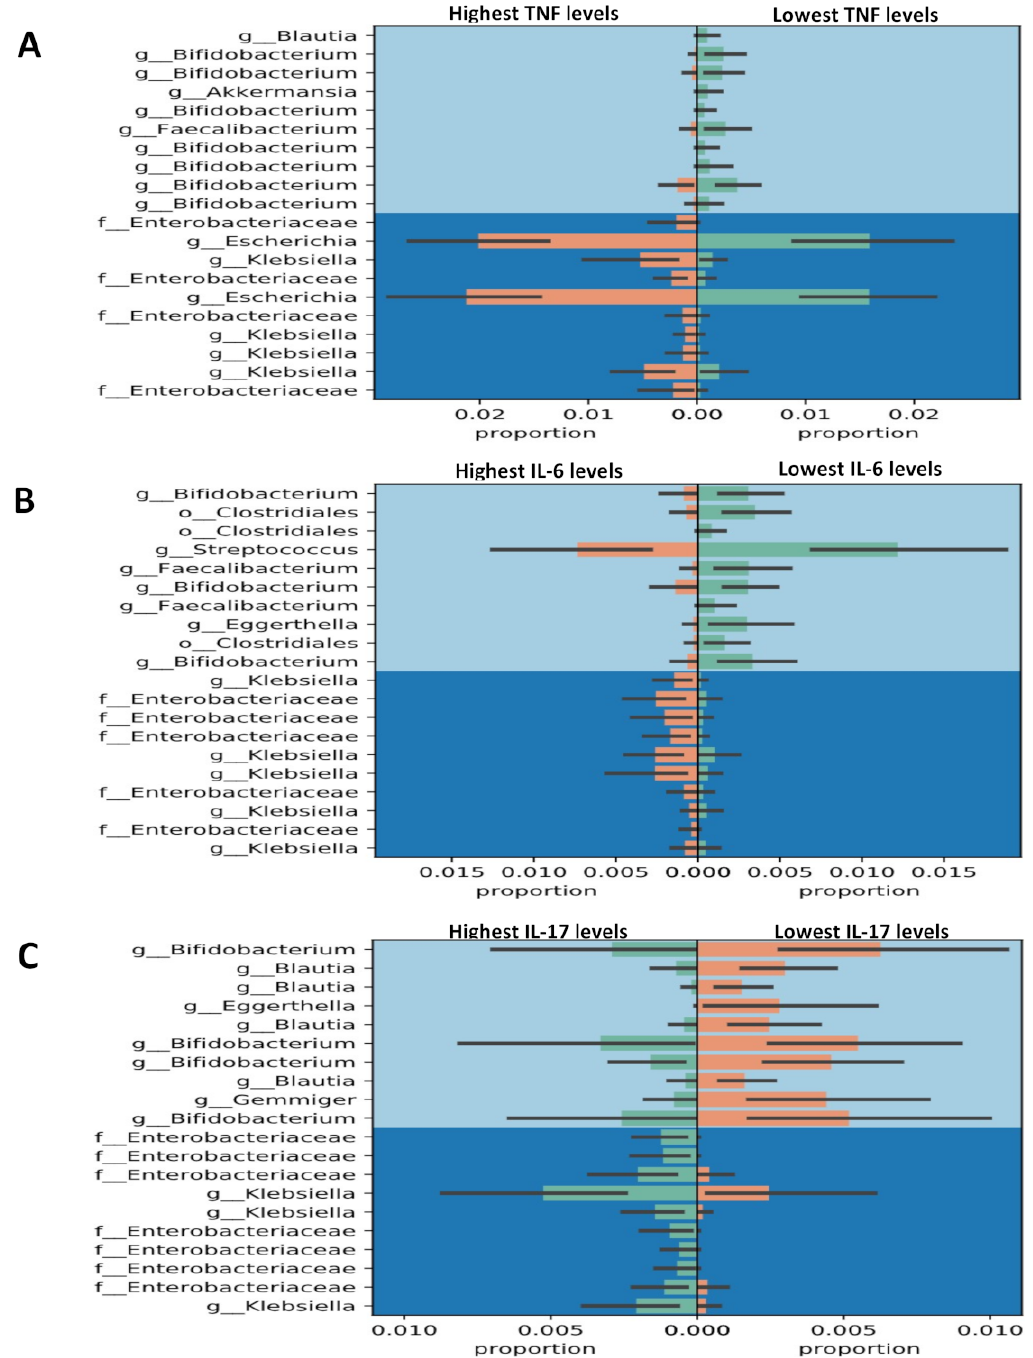
Figure 5. Comparison of the abundances of various bacterial Gneiss in gut microbiota between the highest and lowest levels of cytokines in patients with rheumatoid arthritis (RA). TNF- α : tumor necrosis factor- α ; IL-6: interleukin-6; IL-17A: interleukin-17A. Serum levels of cytokines were stratified into quartiles levels from the lowest (the 1st quartile) to highest (the 4th quartile)